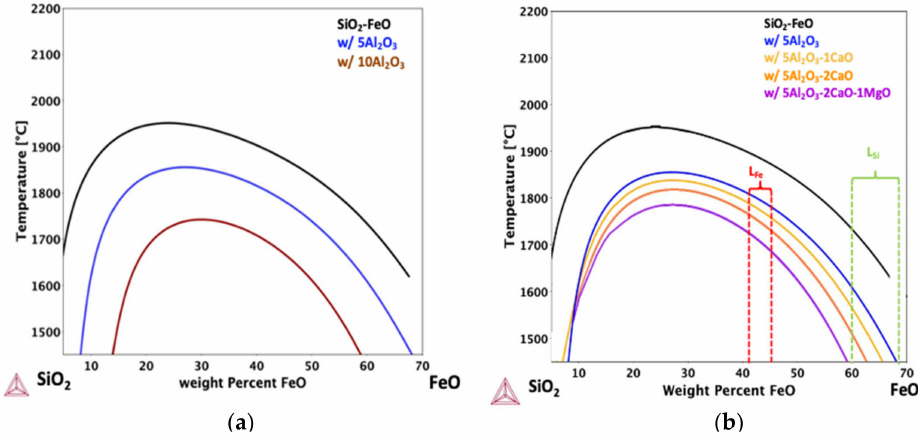
Figure 2. Compositional and temperature sensitivity to ( a ) Al 2 O 3 and ( b ) Al 2 O 3 with CaO and MgO. The labels indicate the weight percent composition for each of the oxide species. The dashed areas ( b ) indicate the bulk composition ranges of the LSi-dispersed (labeled LSi) and LFe-dispersed (labeled Lfe) measured by SEM and